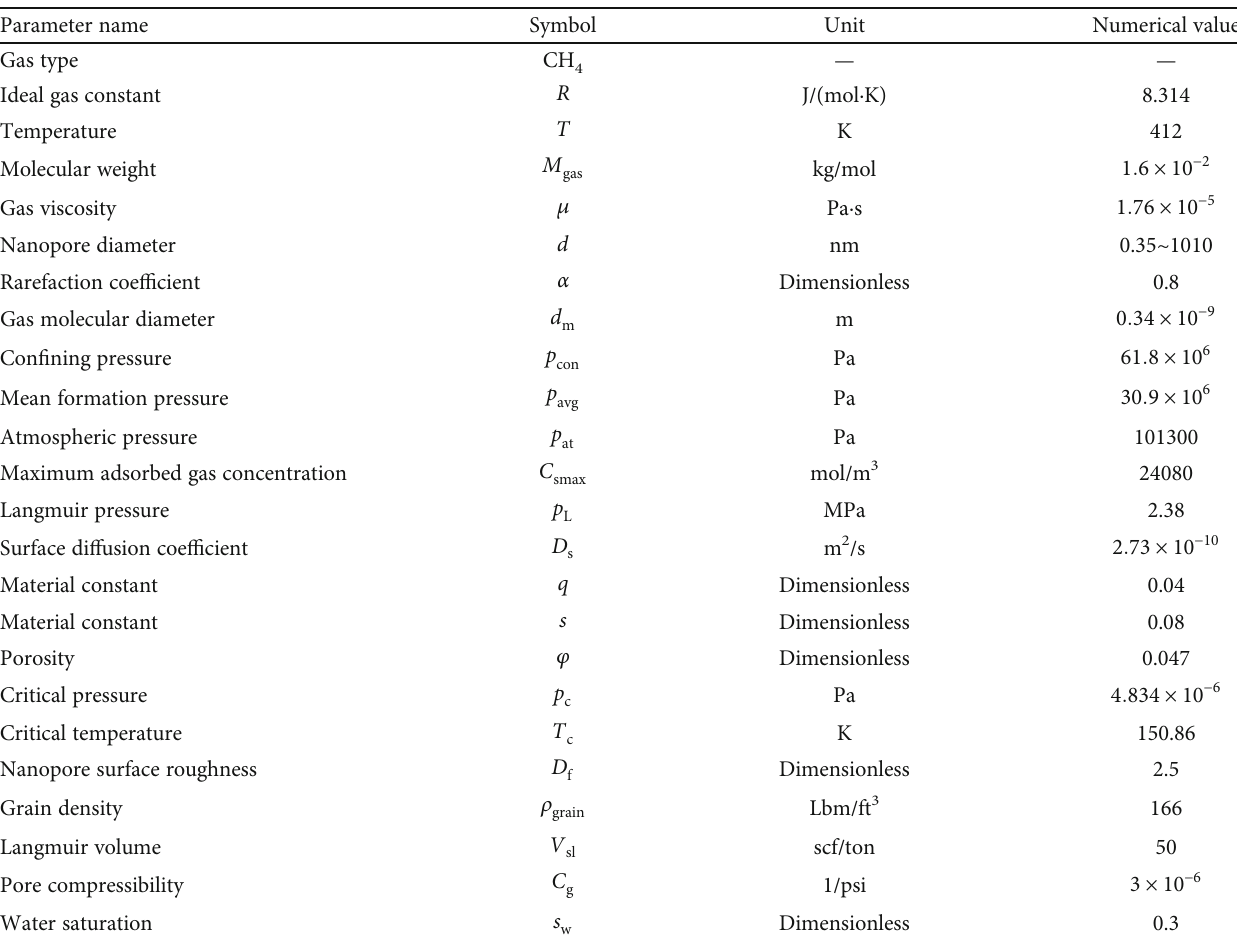
Table 2: Basic simulation